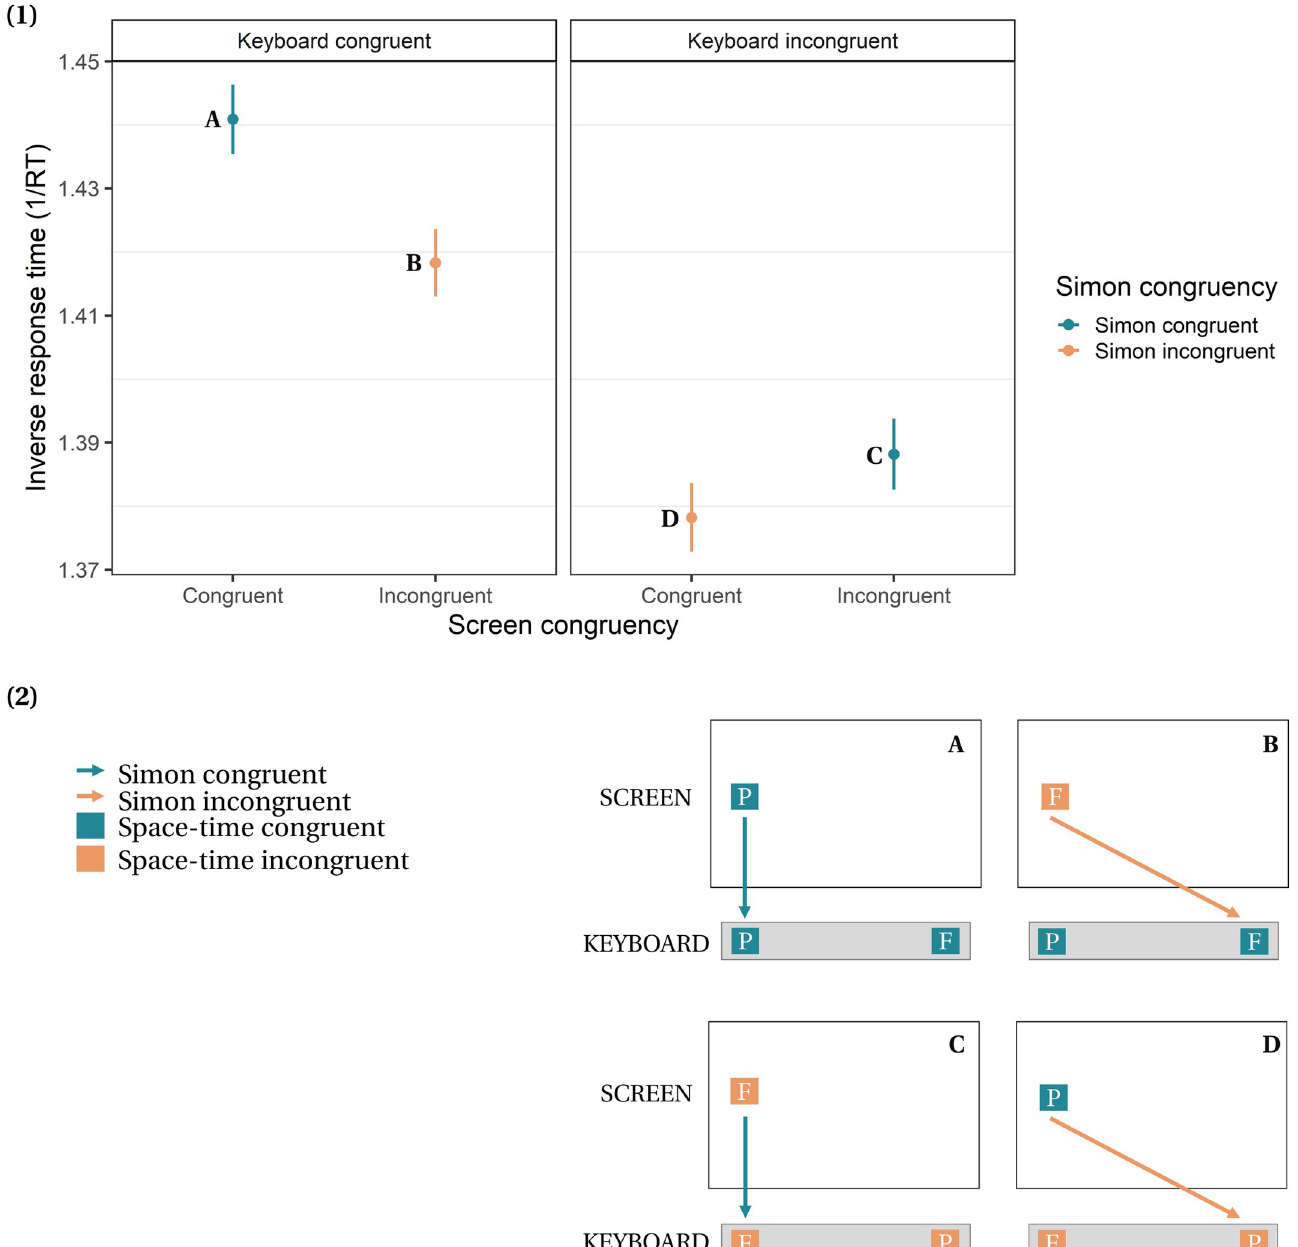
Fig 3. (1) Inverse response latencies (i.e., higher values correspond to faster responses) for all types of congruencies, as resumed in (2) . Error bars represent standard errors of the mean.